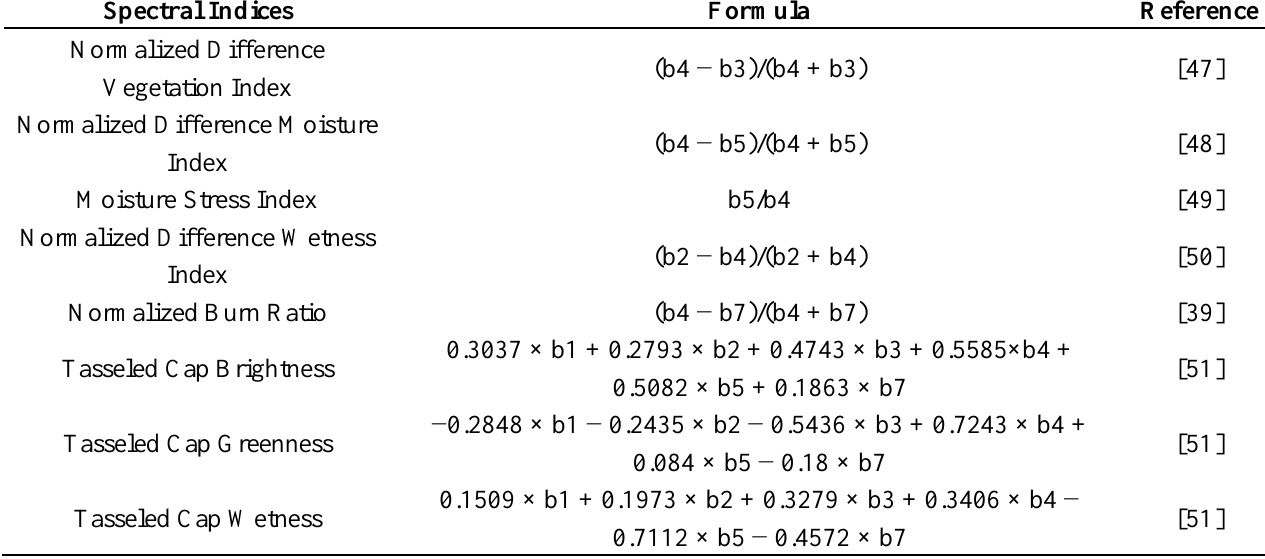
Table 5. Spectral indices used in the single-date classifications, including formulas and